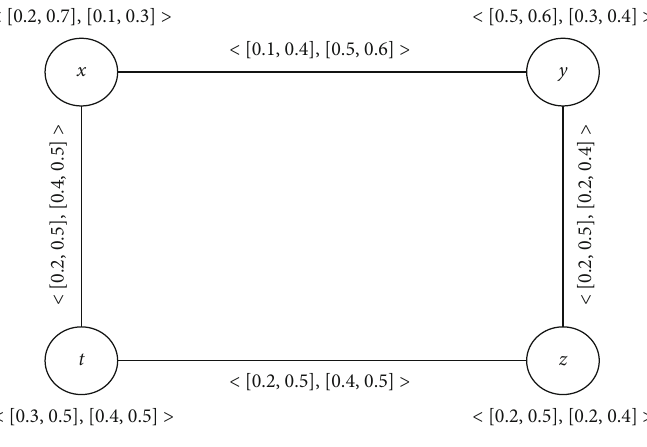
Figure 6: An IVIFG G for strong paired dominating set (SPDS). Table 7: Calculating the weight of paired dominating sets.